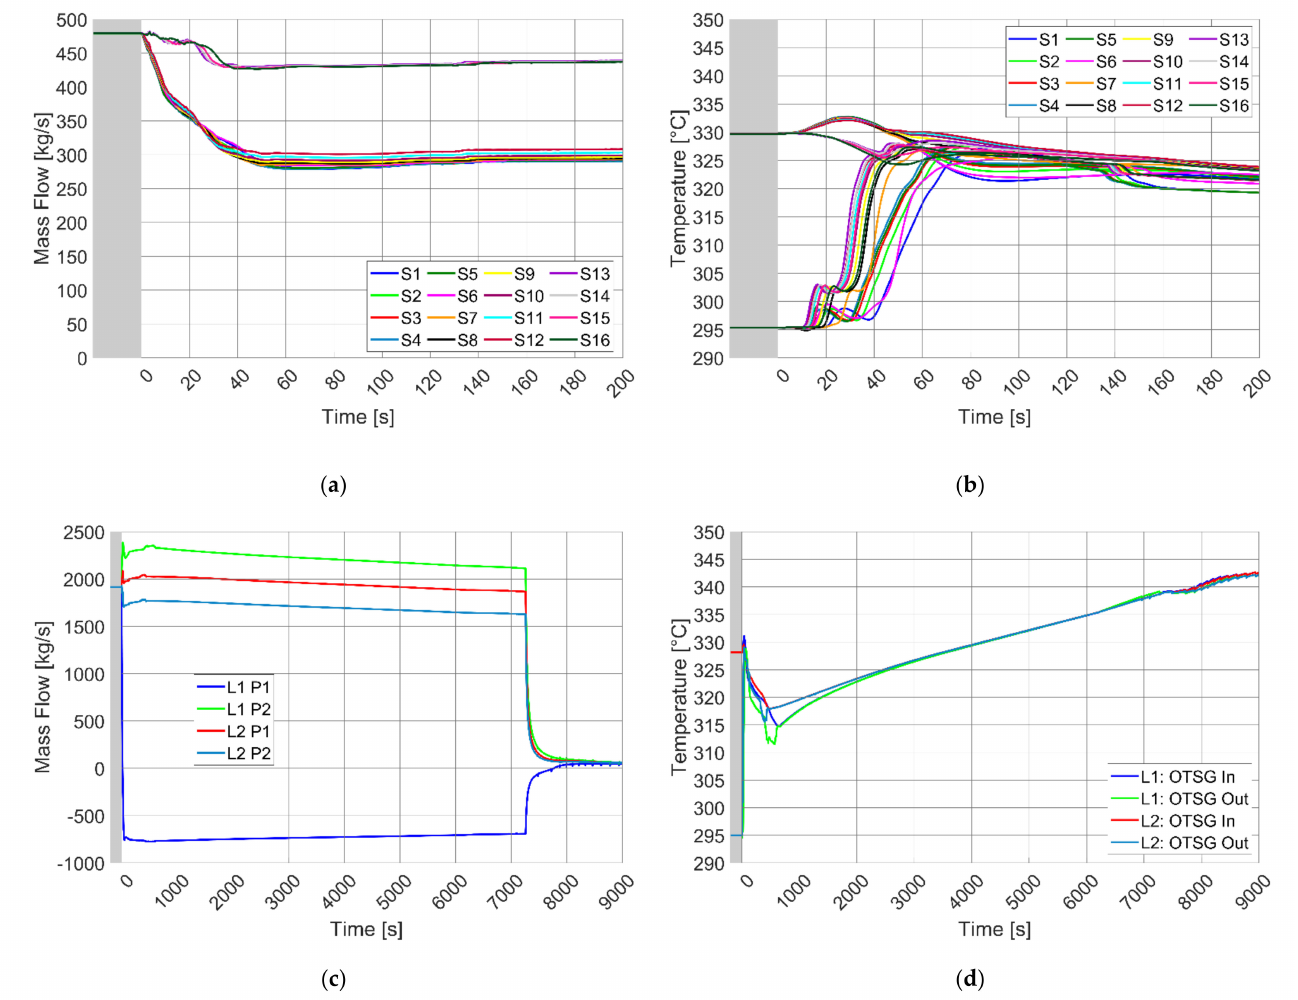
Figure 11. Partial LOFA on BZ PHTS without loss of off-site power (LF3 transient): ( a ) Mass flow in BZ sectors (early time); ( b ) BZ PHTS water temperatures at BB inlet & outlet (all sectors, early time, COB segment); ( c ) Mass flow elaborated by BZ PHTS MCPs (full range); ( d ) BZ PHTS water temperatures at OTSGs inlet & outlet (full